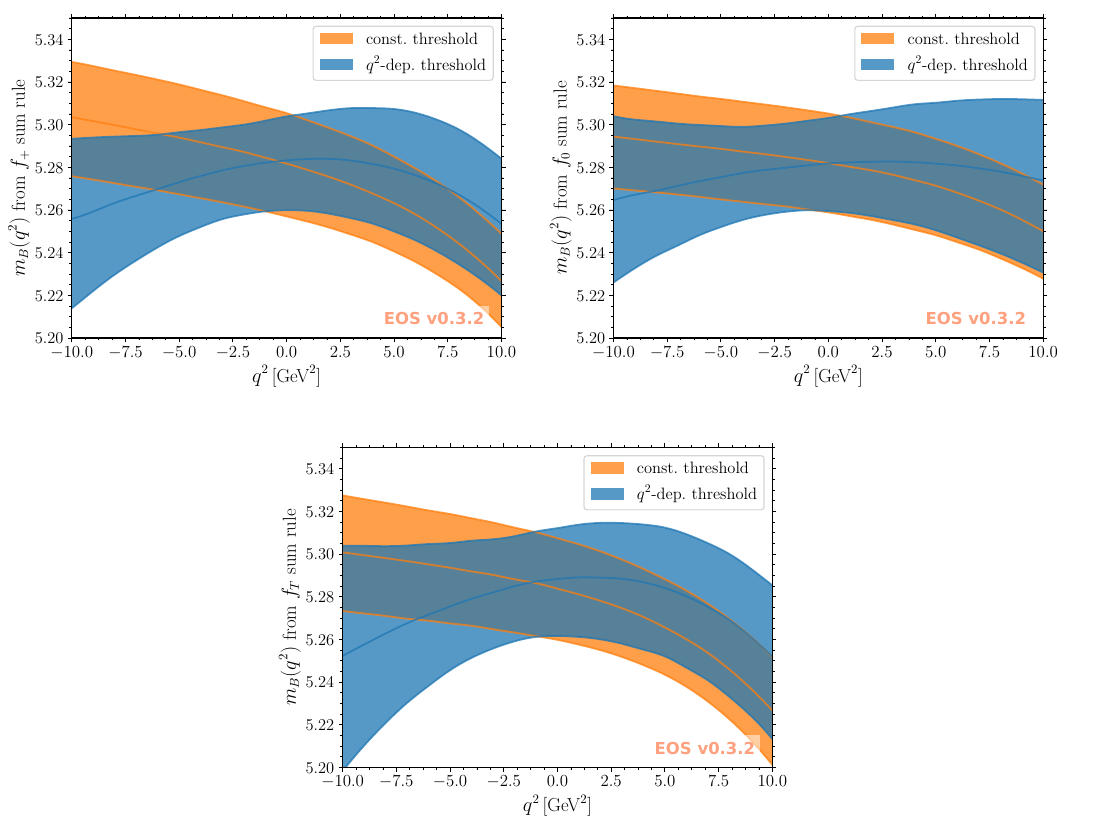
Figure 1 . The dependence of the B -meson mass predictor [ m 2 form factors F = { f + , f 0 , f T } on the momentum transfer q 2 . We show the posterior-prediction for a q 2 -invariant threshold (in orange) and a threshold with linear q 2 dependence as in eq. (2.3) (in blue). The shaded areas correspond to the respective 68% probability envelopes.